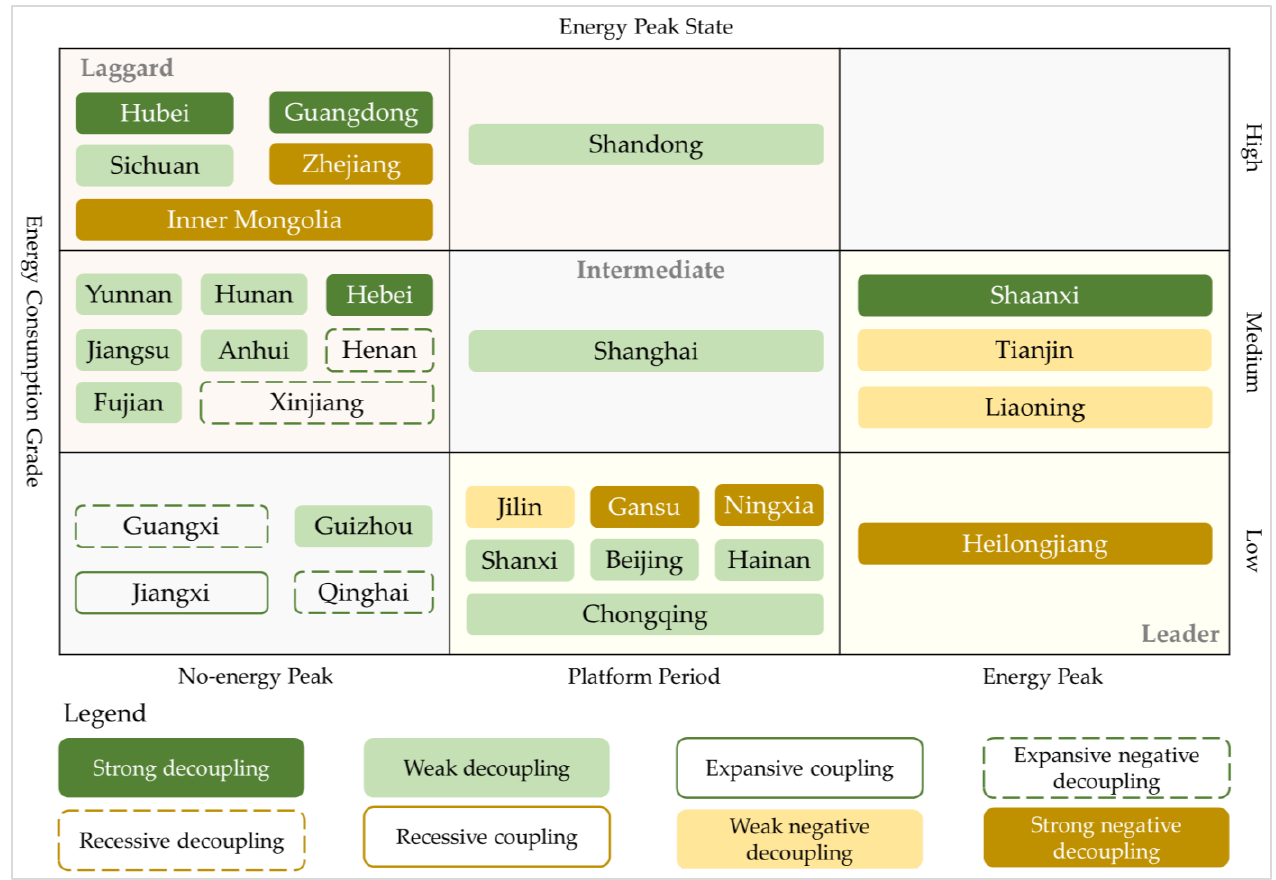
Figure 16. Optimized policy zoning of energy consumption on China’s construction industry.